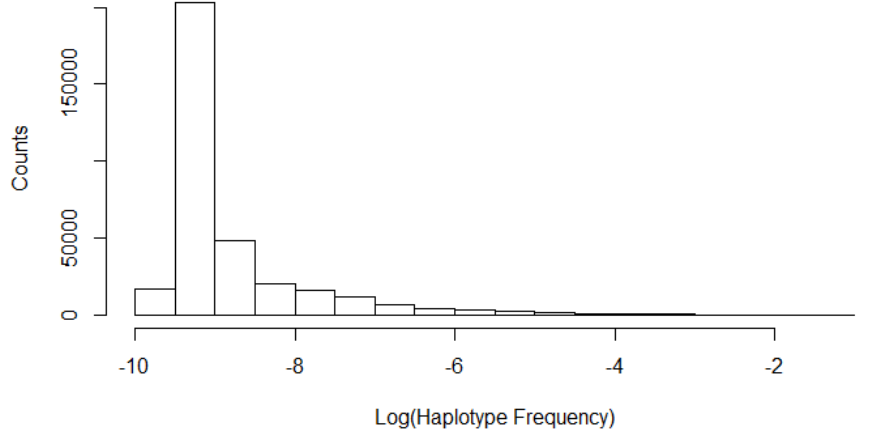
Figure 1. Distribution of haplotype block frequency (log scale) of 339,824 blocks, 100 SNPs in width, estimated from a population of 5334 genotyped Australian Wagyu.